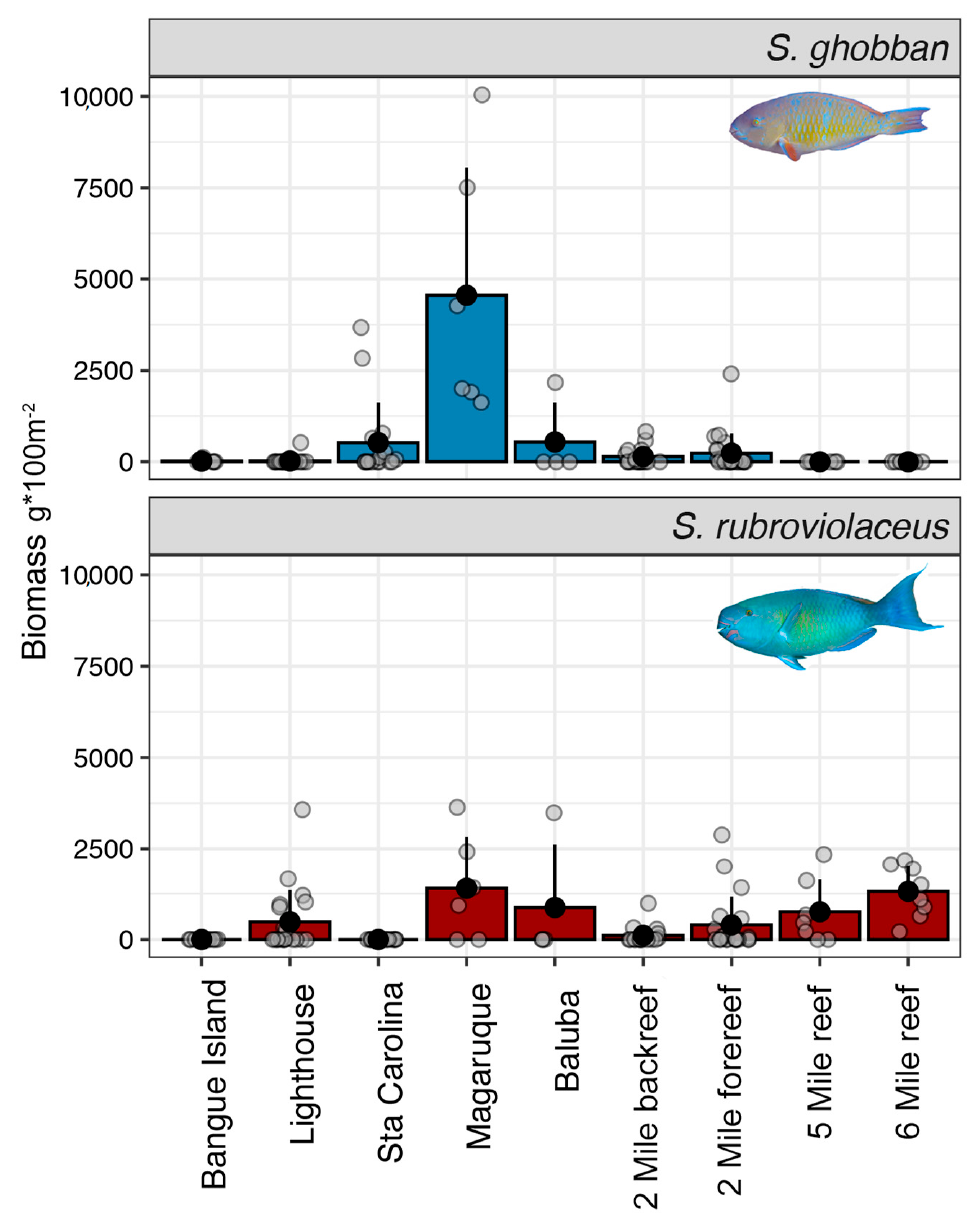
Figure A4. Biomass of S. ghobban and S. rubroviolaceus at the surveyed reefs ordered by distance to seagrass